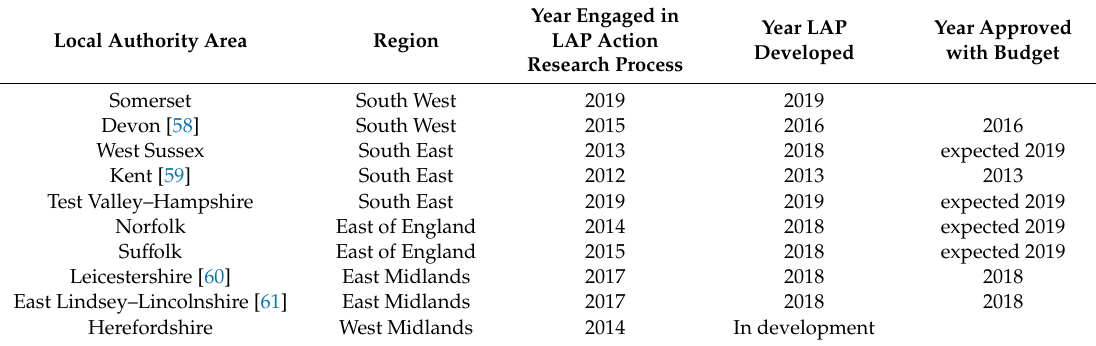
Table 2. Local authorities with local action plans (LAP) for managing ash dieback as of June